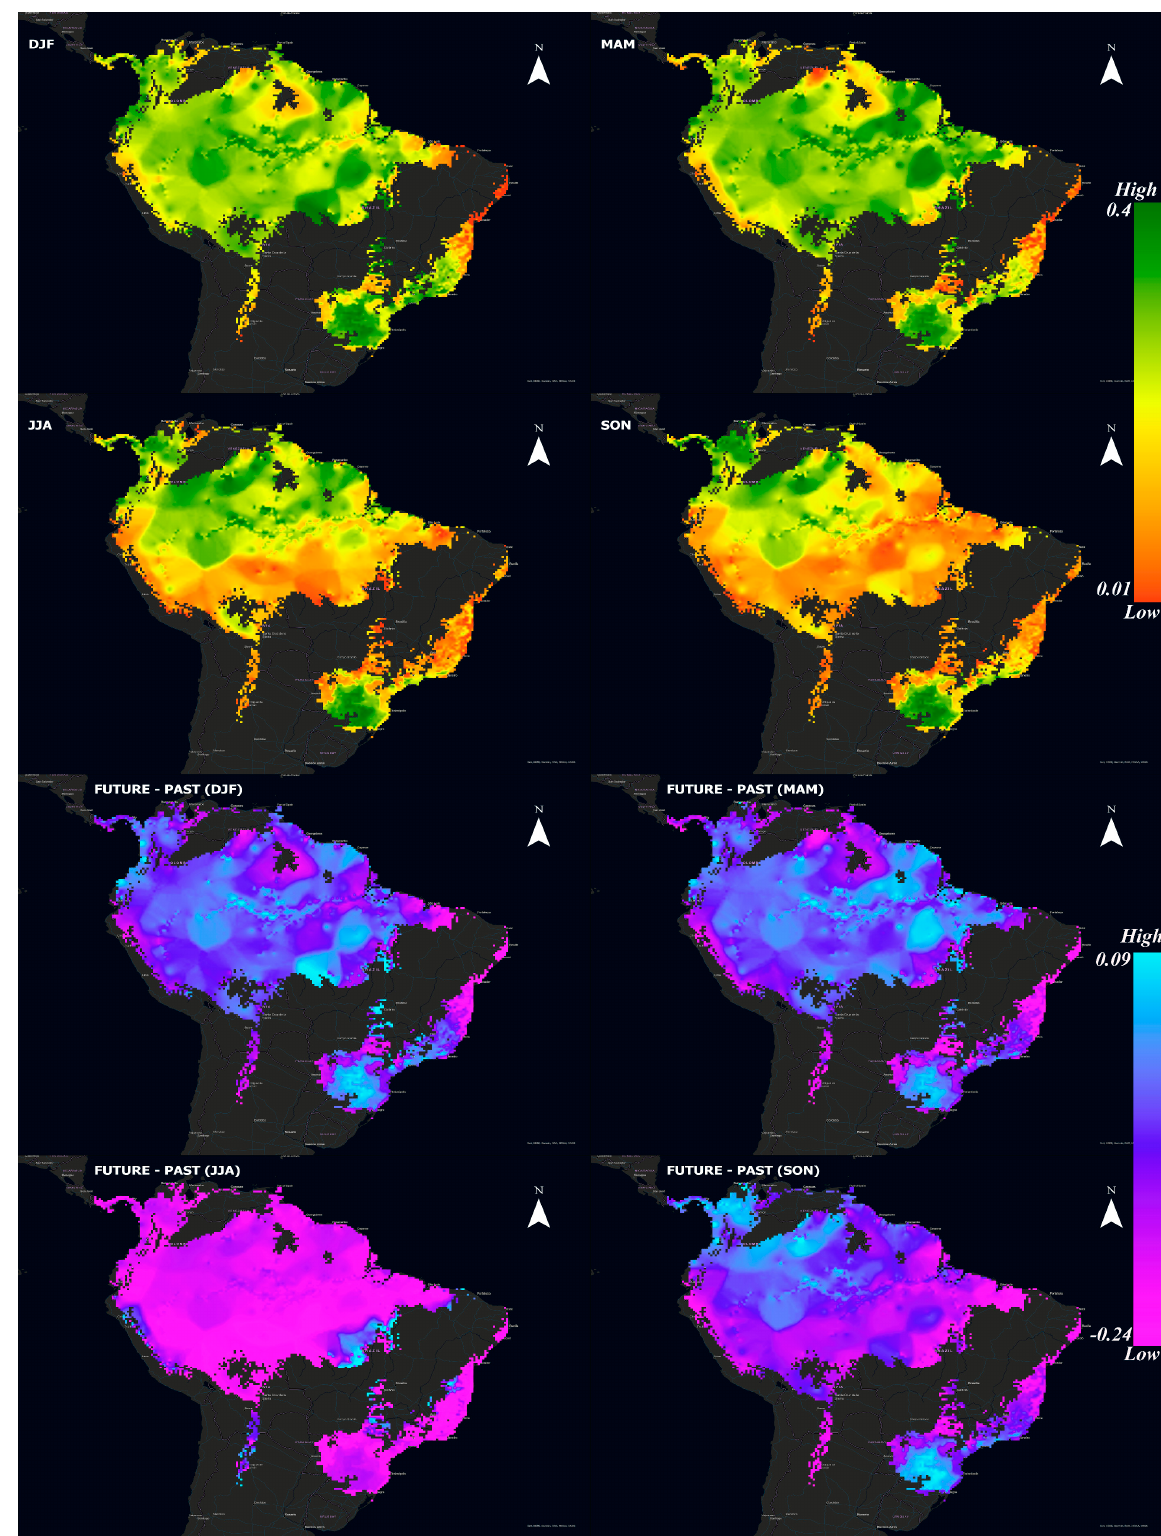
Figure 8. Spatial distribution of future VSM (m 3 m − 3 ) for the 2022–2050 climate quarters and the difference between future and past